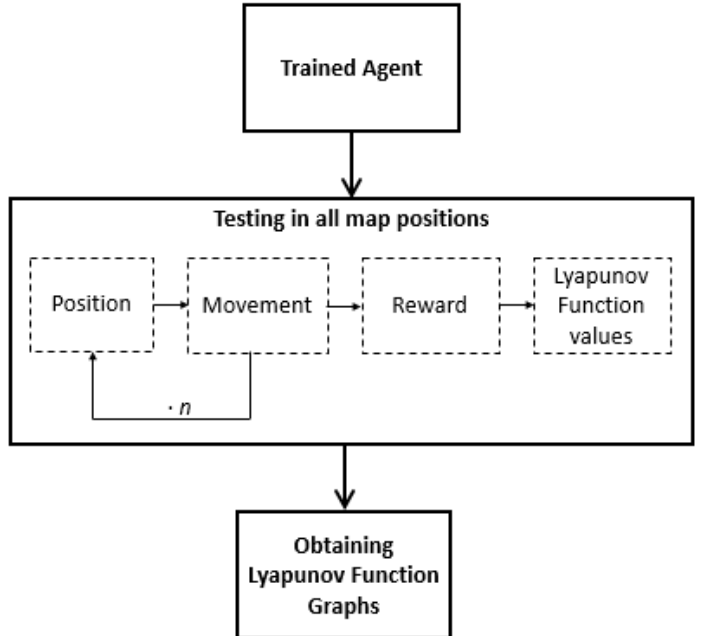
Figure 2. Flowchart of the Lyapunov function surface graphics